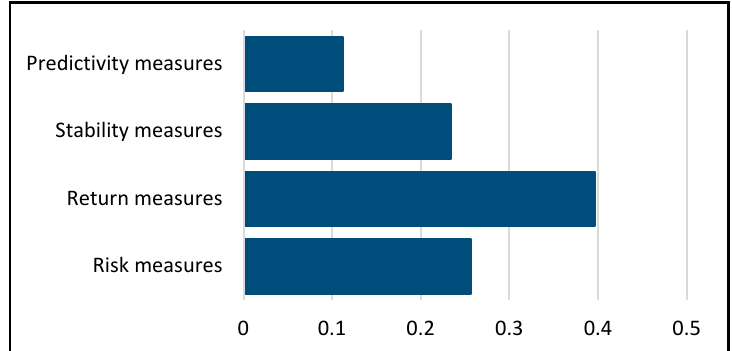
Figure 2. Estimation of criteria weights using Expert Choice.